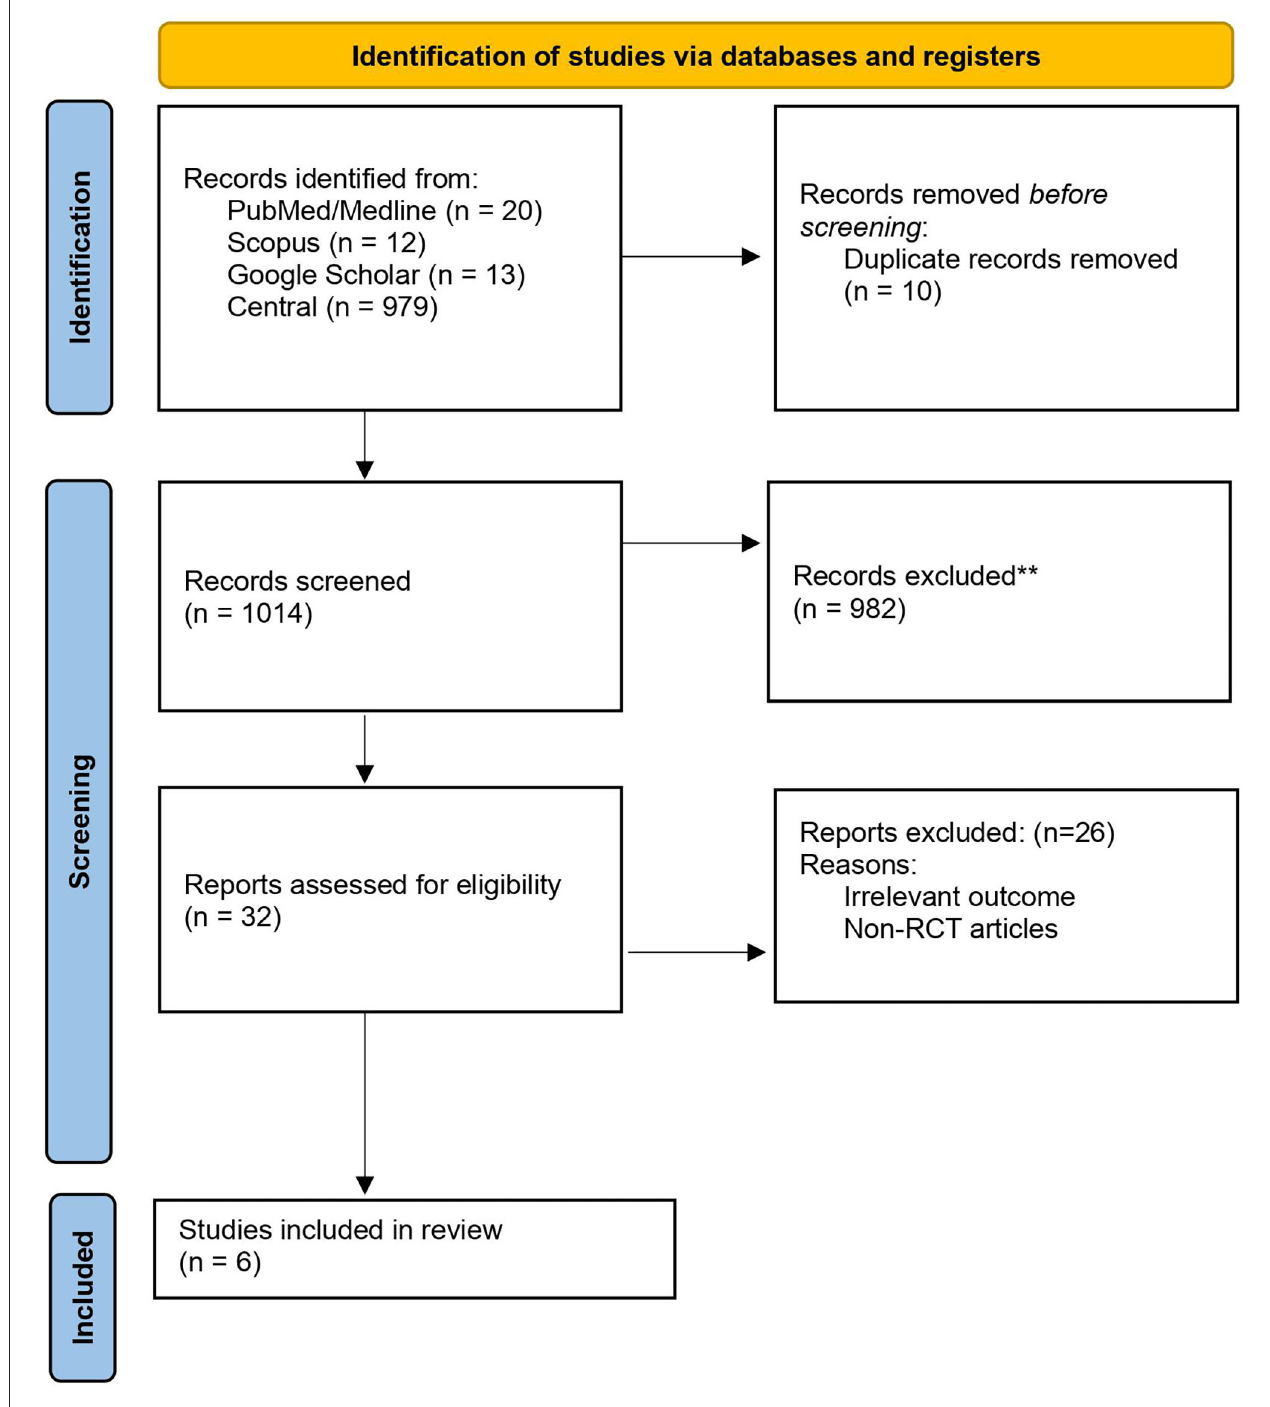
FIGURE 1 | A PRISMA 2020 flow diagram.